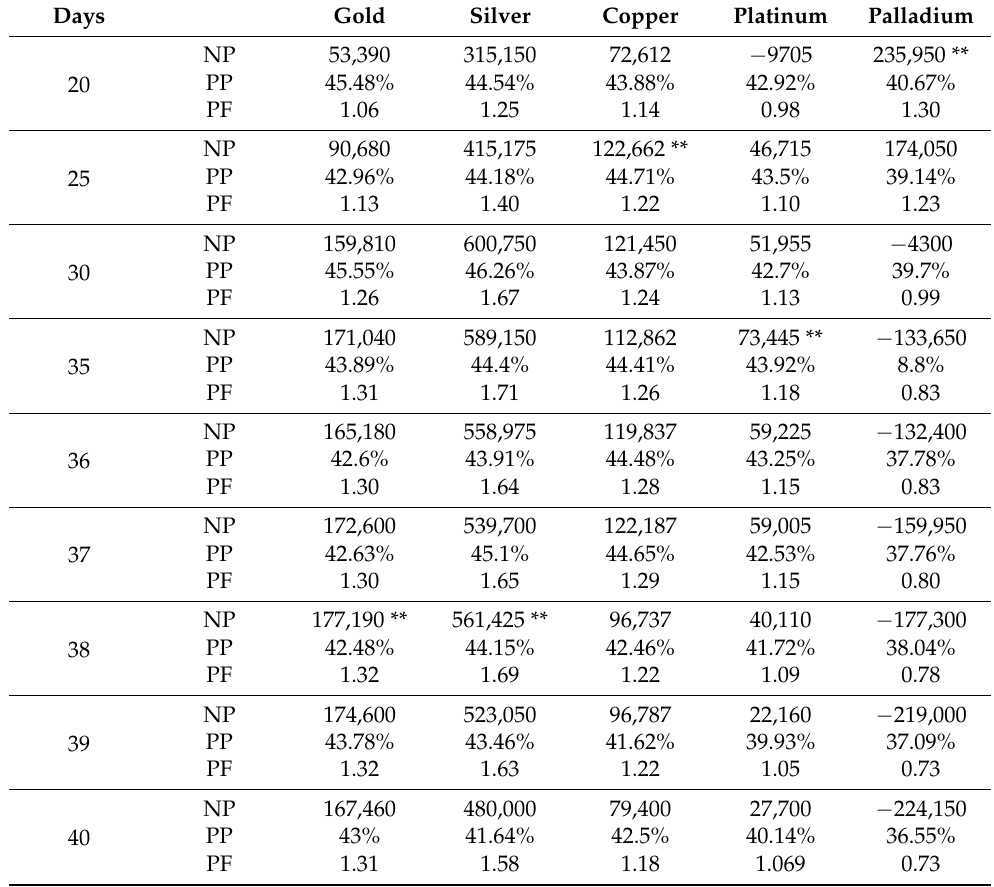
Table 3. Linear regression strategy trading results.